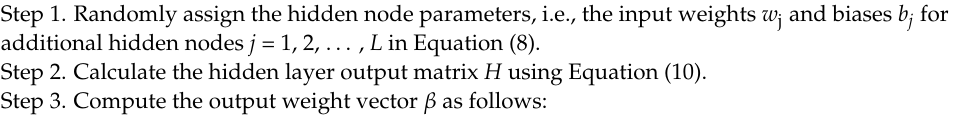
Algorithm 2. Fast ELM Learning